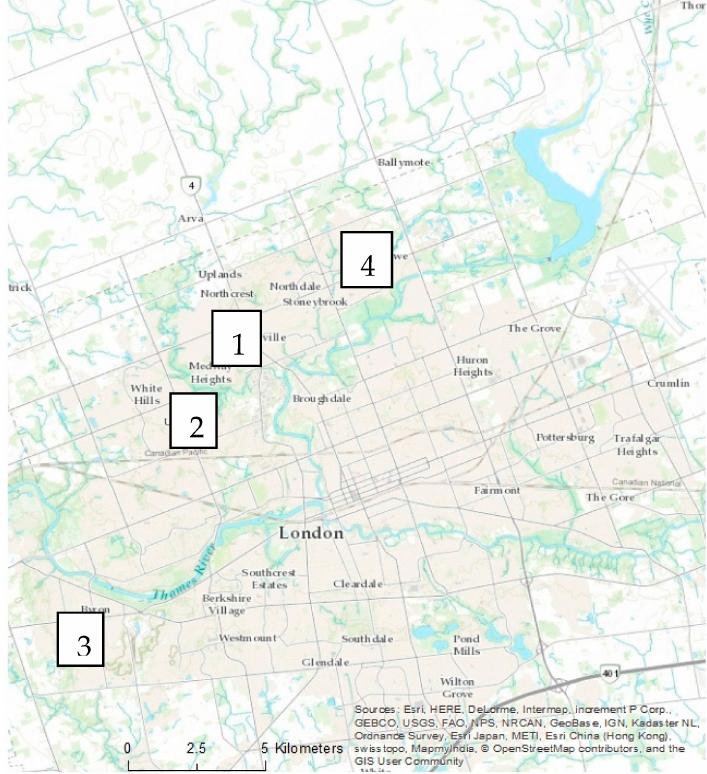
Figure A3. The neighbourhoods examined in London: Masonville ( 1 ); Sherwood Forest ( 2 ); Byron ( 3 ); and Stoney Creek ( 4 ).